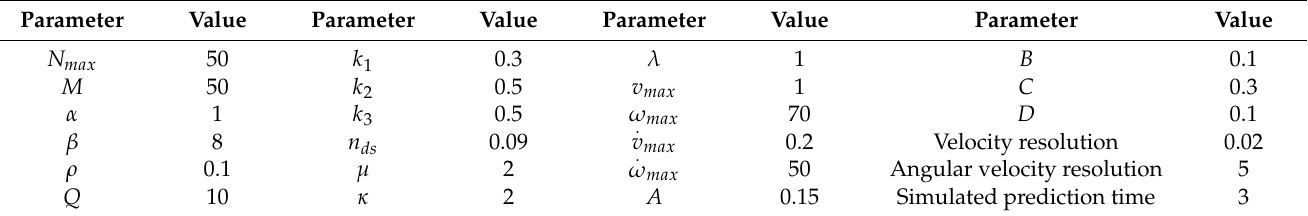
Table 3. Main parameters of simulation experiment.